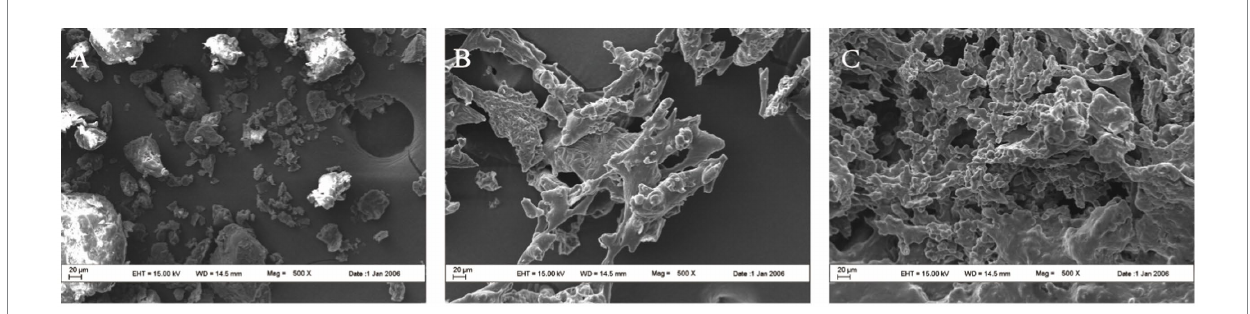
FIGURE 1 Effect of fermentation on the structure of WG. (A) Fermented gluten for 0 h. (B) Fermented gluten for 72 h. (C) Fermented gluten for 168